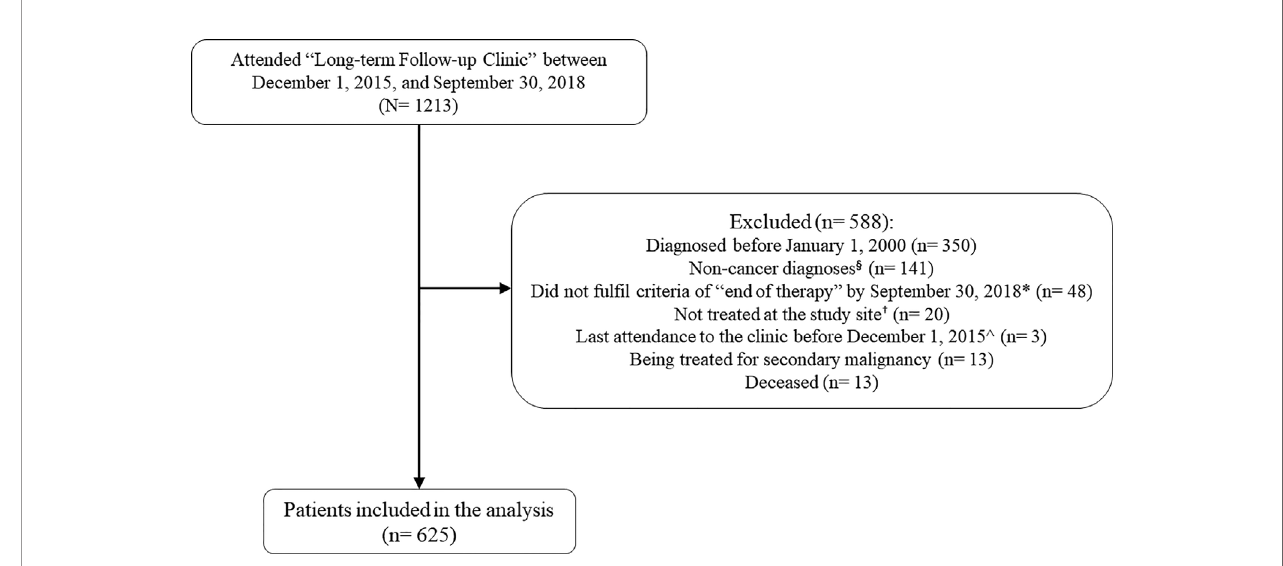
FIGURE 1 | Subject screening. § The “ Long-term Follow-Up Clinic ” of the study site (Prince of Wales Hospital) provides follow-up care for survivors of pediatric cancers and hematology diseases. Patients who were diagnosed with non-cancer conditions (e.g. aplastic anemia, thalassemia, etc.) were excluded. * “ End-of- treatment ” is de fi ned as more than 30 days from the last documented date of chemotherapy, immunotherapy, targeted therapy, radiation, or surgery + Survivors not treated at the study site was excluded as we were not able to retrieve their treatment history. ^Survivors with stable health status are typically scheduled for a follow- up consultation once every 1 to 2.5 years. Survivors whose last attendance to the clinic was before December 2015 were likely lost to follow